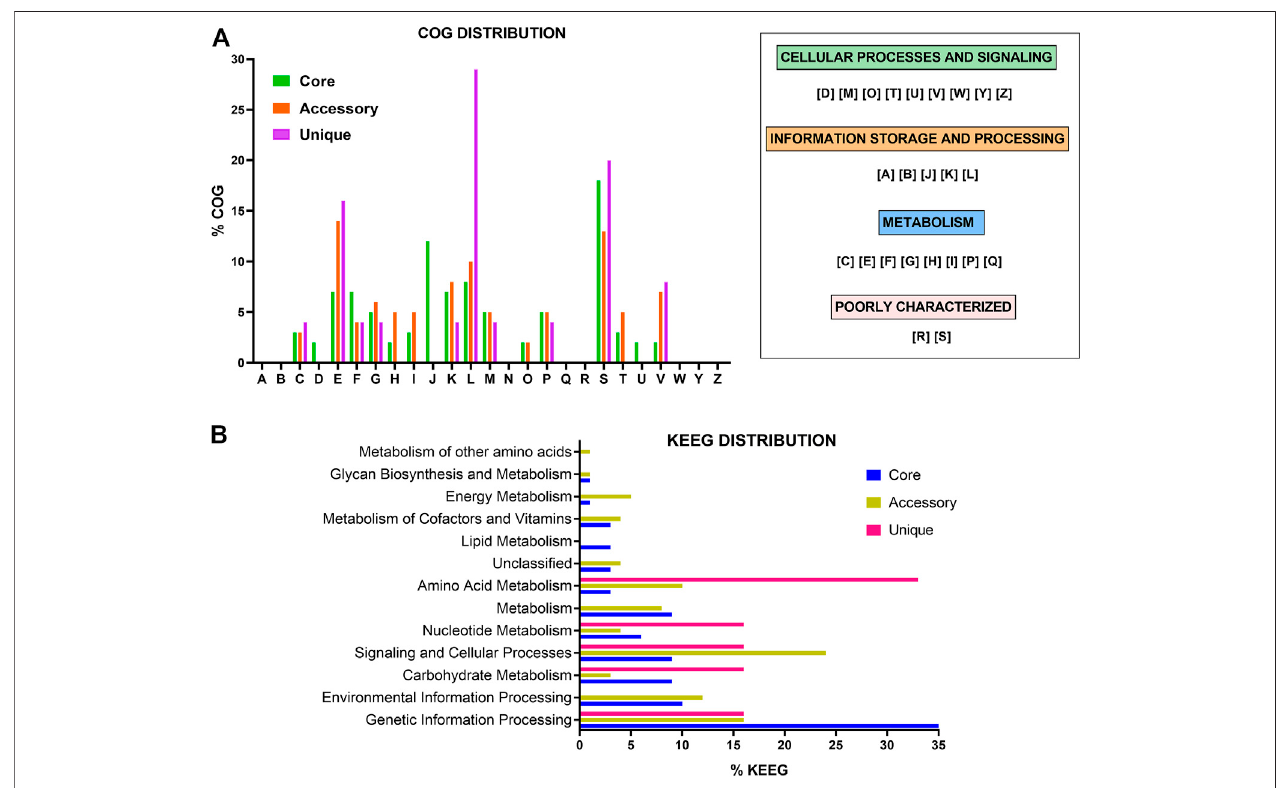
FIGURE 2 | Functional analysis of gene families of probiotics L. delbrueckii strains. Distribution of COG (A) and KEGG (B) functional categories in the core, accessory,and uniquegenes. COGcategories: [A]RNAprocessing and modi fi cation, [B] Chromatin structure and dynamics,[C]Energyproduction and conversion, [D] Cellcyclecontrol,celldivision,chromosomepartitioning, [E]Aminoacidtransportandmetabolism,[F]Nucleotidetransportandmetabolism,[G]Carbohydratetransport andmetabolism,[H]Coenzymetransportandmetabolism,[I]Lipidtransportandmetabolism,[J]Translation,ribosomalstructureandbiogenesis,[K]Transcription, [L] Replication, recombination and repair, [M] Cell wall/membrane/envelope biogenesis, [N] Cell motility, [O] Post-translational modi fi cation, protein turnover, and chaperones, [P] Inorganic ion transport and metabolism, [Q] Secondary metabolites biosynthesis, transport, and catabolism, [R] General function prediction only, [S] Function unknown, [T] Signal transduction mechanisms, [U] Intracellular traf fi cking, secretion, and vesicular transport, [V] Defense mechanisms, [W] Extracellular structures, [Y] Nuclear structure, and [Z]